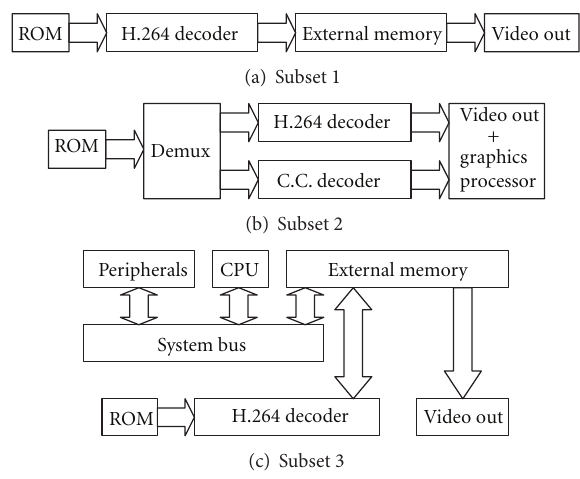
F 6: Subsets of SoC IPs used for incremental development.